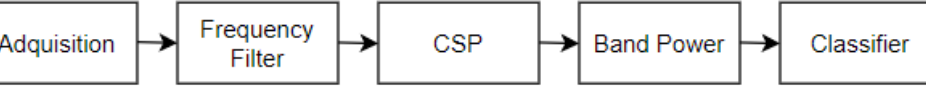
Figure 7. Signal Processing Procedure.